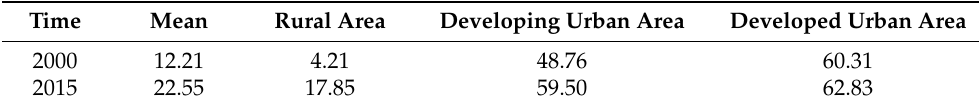
Figure 2. Urbanization ( a ) in 2000–2015 and ( b ) classification of urbanization in study area. Table 2. The average DN of night light data in different areas in 2000 and 2015.